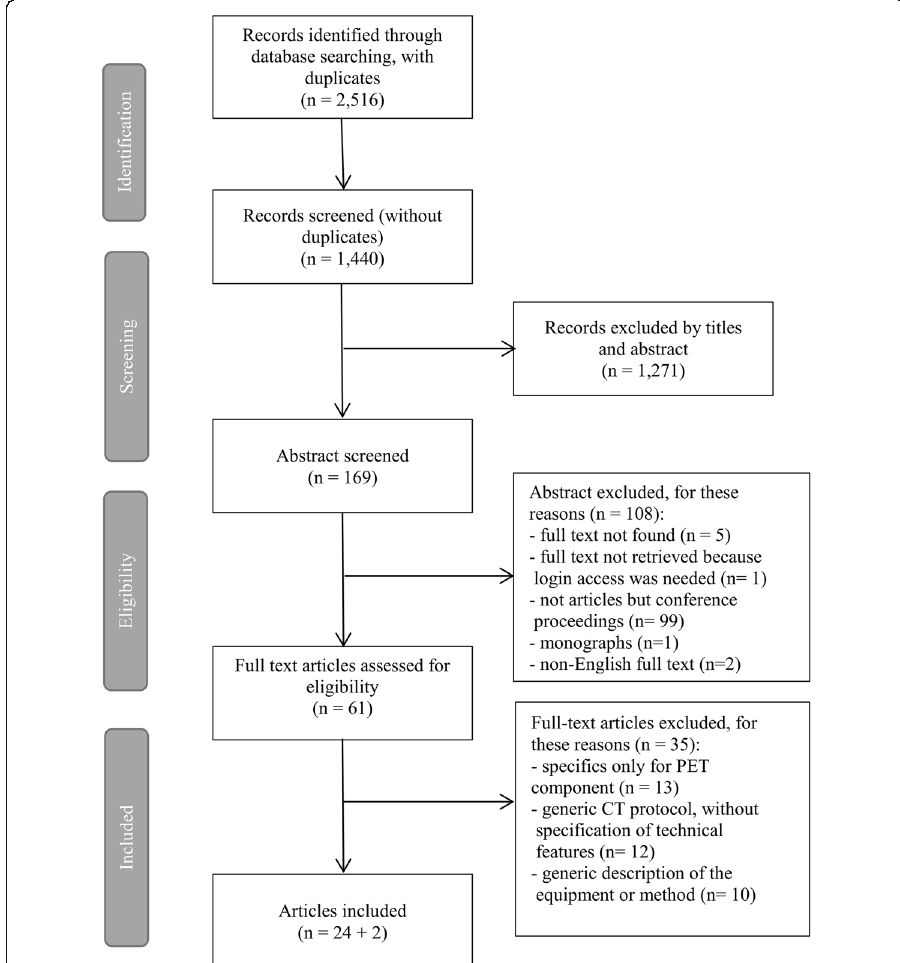
Fig. 1 PRISMA-P flow chart: articles selection